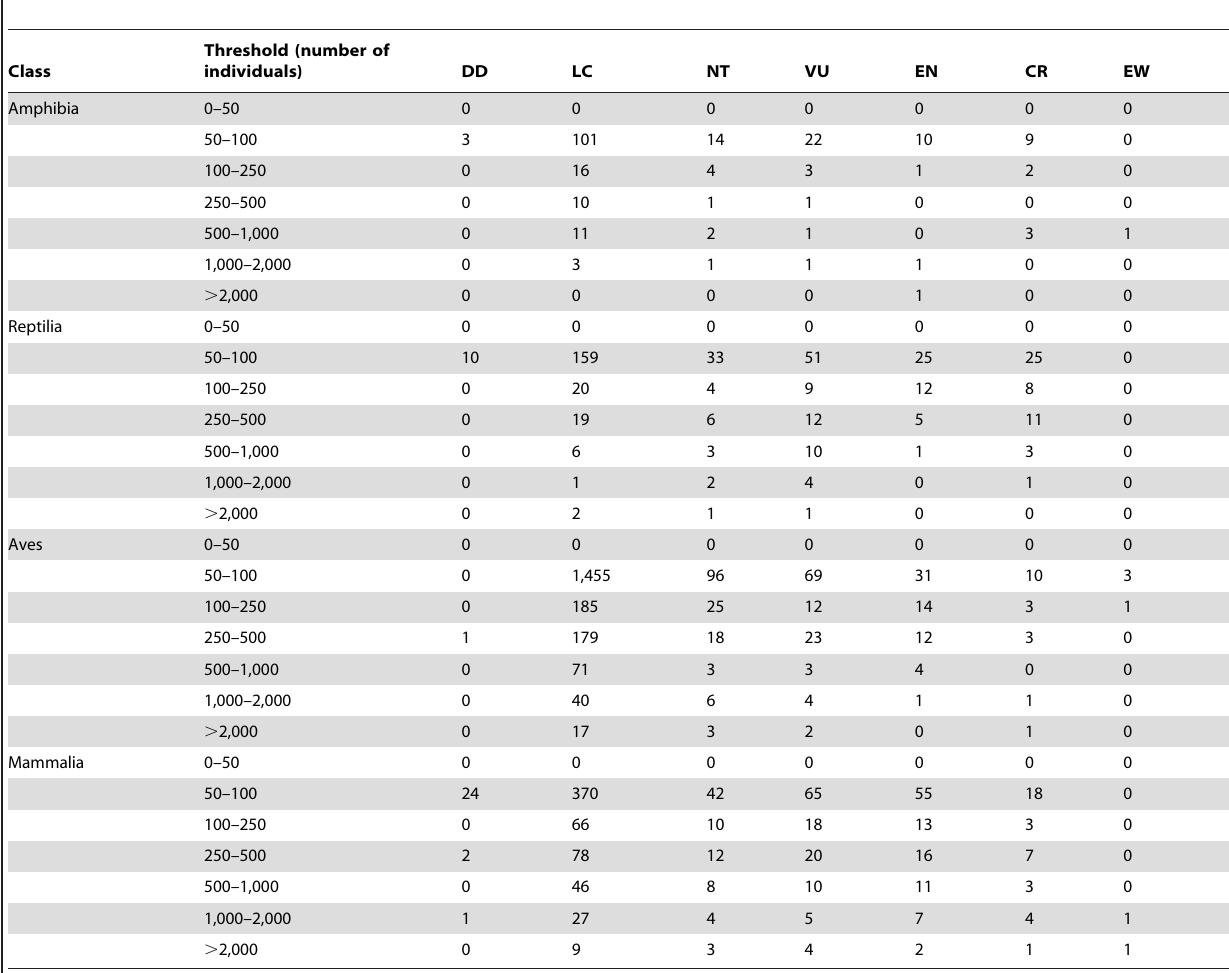
Table 3. Number of species in ISIS zoos with population sizes within specific thresholds for the different Red List categories (see Table 2 for Red List categories